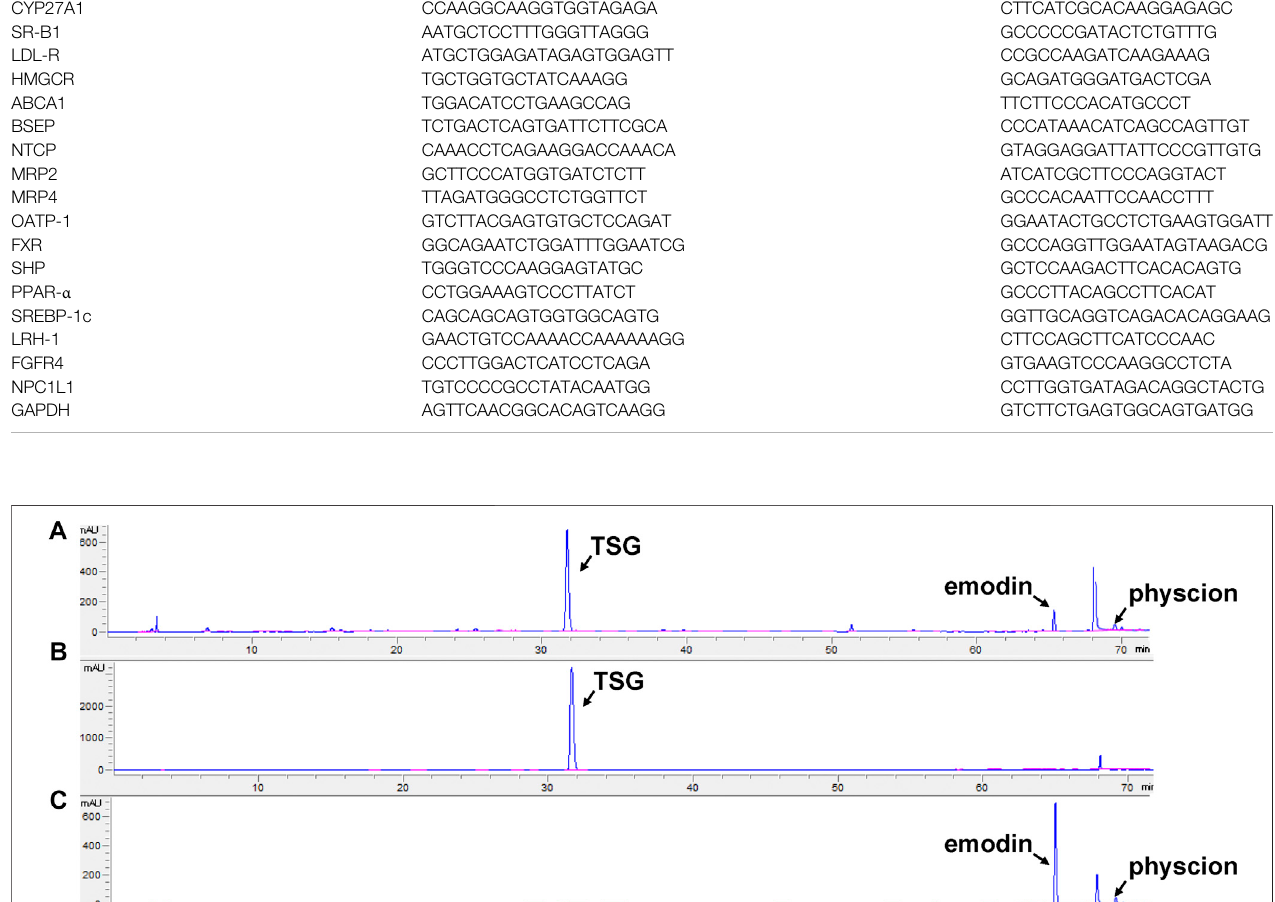
Frontiers in Pharmacology |